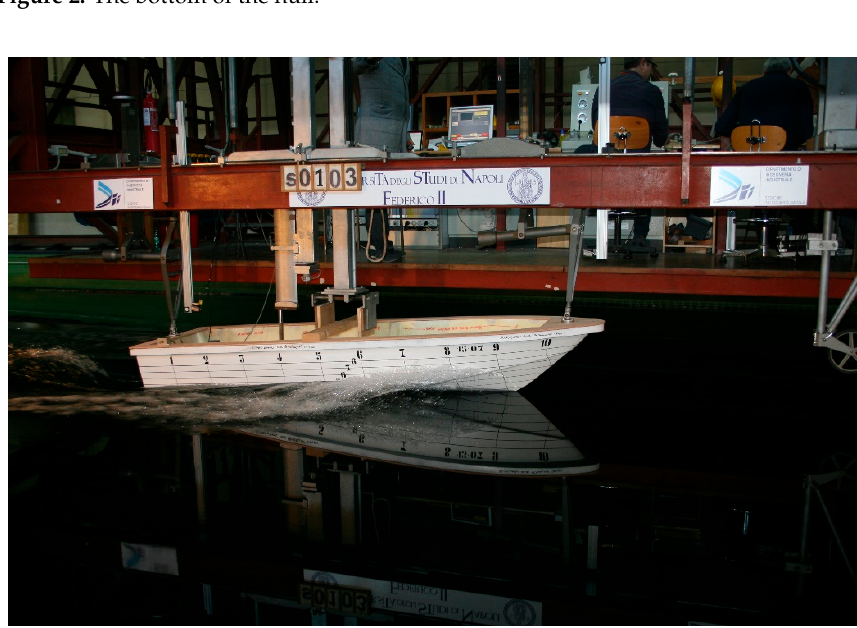
Figure 3. A test in towing tank.